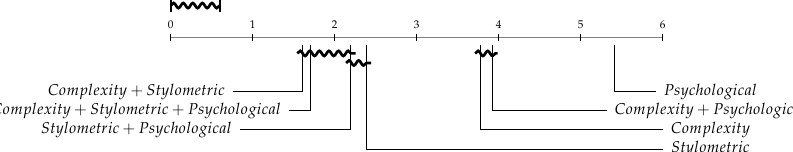
Figure 6. Nemenyi post hoc test for all feature category